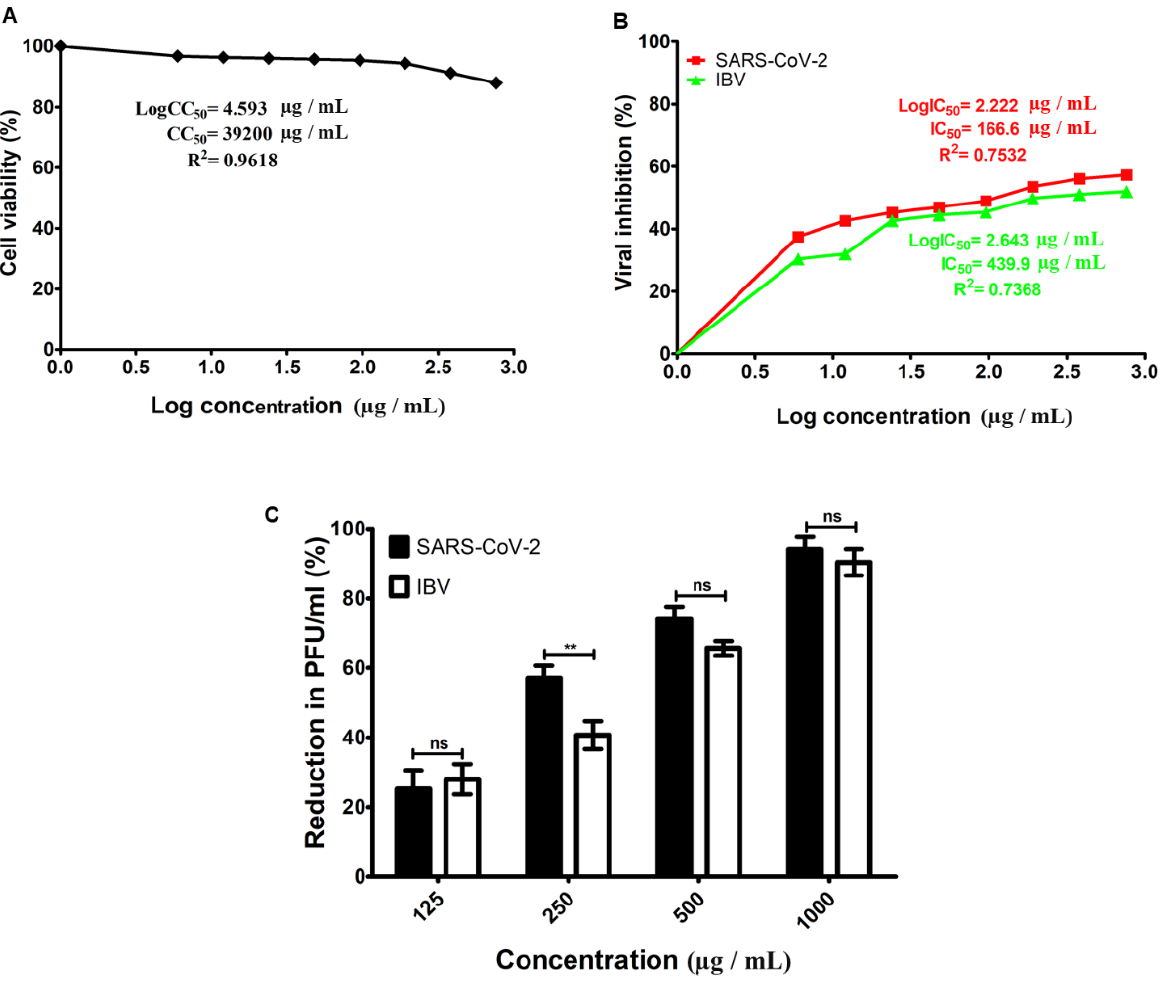
Figure 2. Cytotoxicity and antiviral activity of hWJ-MSC-S. ( A ) Cytotoxicity concentration (CC 50 ) of hWJ-MSC-S on Vero-E6 cells. Cells were treated with different concentrations of hWJ-MSC-S for 24 h. The cytotoxicity levels were measured using an MTT assay. ( B ) Half-maximal inhibitory concentration (IC 50 ) of hWJ-MSC-S against SARS-CoV-2 infection (red line) and IBV infection (green line) in Vero-E6 cells. Virus incubated with different concentrations of hWJ-MSC-S for 1 h before infecting Vero-E6 cells. The IC 50 was calculated as the concentration of hWJ-MSC-S that was required to reduce the virus-induced cytopathic effect (CPE) by 50%, compared to the virus control. ( C ) Reduction in plaque formation after treatment of SARS-CoV-2 and IBV with different concentrations of hWJ-MSC-S (125, 2,505,001,000 µ g/mL). IC 50 and CC 50 values were calculated using nonlinear regression analysis by plotting log inhibitor versus normalized response (Variable slope). Results are shown as means ± SD of three independent experiments, each run in triplicate. The p value ** p < 0.01 indicates the significant correlation between the antiviral activities of hWJ-MSC-S against SARS-CoV-2 vs